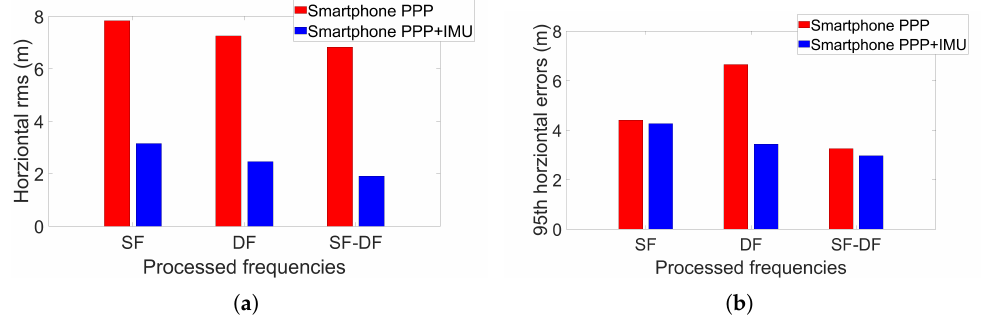
Figure 12. Overall horizontal errors from different processing strategies. ( a ) Overall horizontal rms comparison. ( b ) 95th percentile horizontal errors comparison. Table 10. Overall statistics for different processing